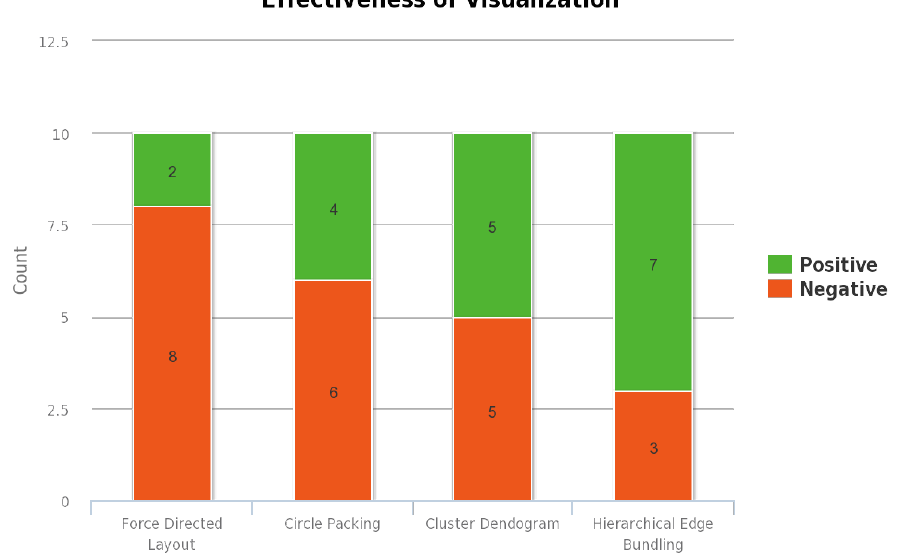
Figure 2. Stacked bar chart representing the distribution of effectiveness for all the visualizations.